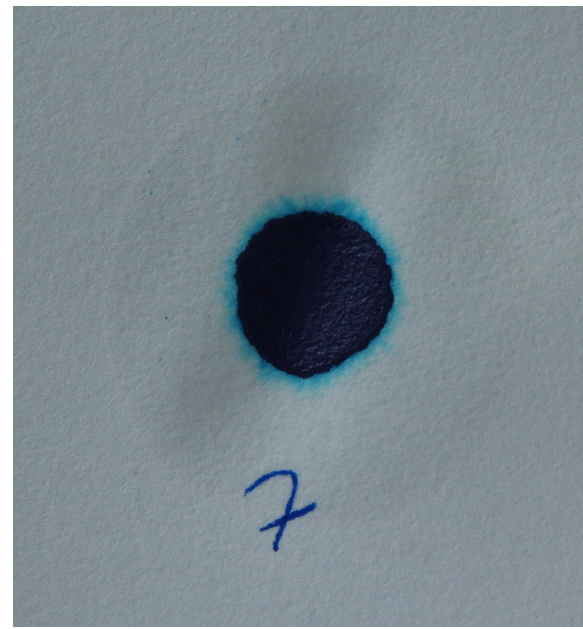
Figure 4. A blue ring around a drop of